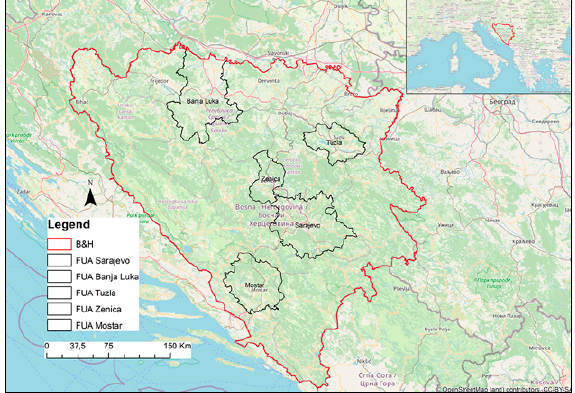
Figure 1. Location of B&H and